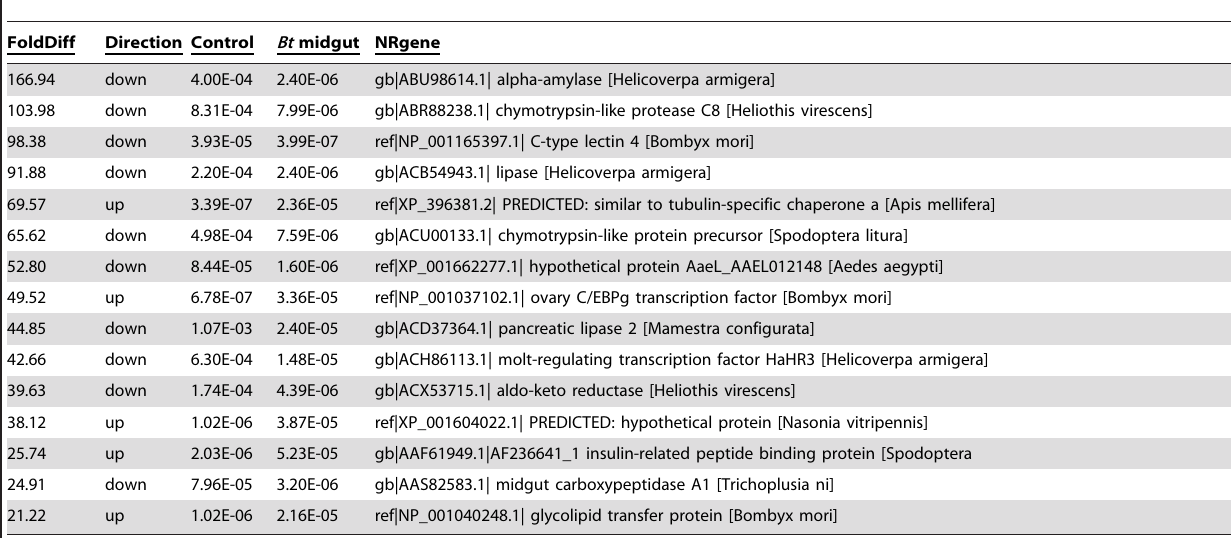
Table 2. The 15 gypsy moth genes having the largest digital gene expression level perturbations following Bacillus thuringiensis